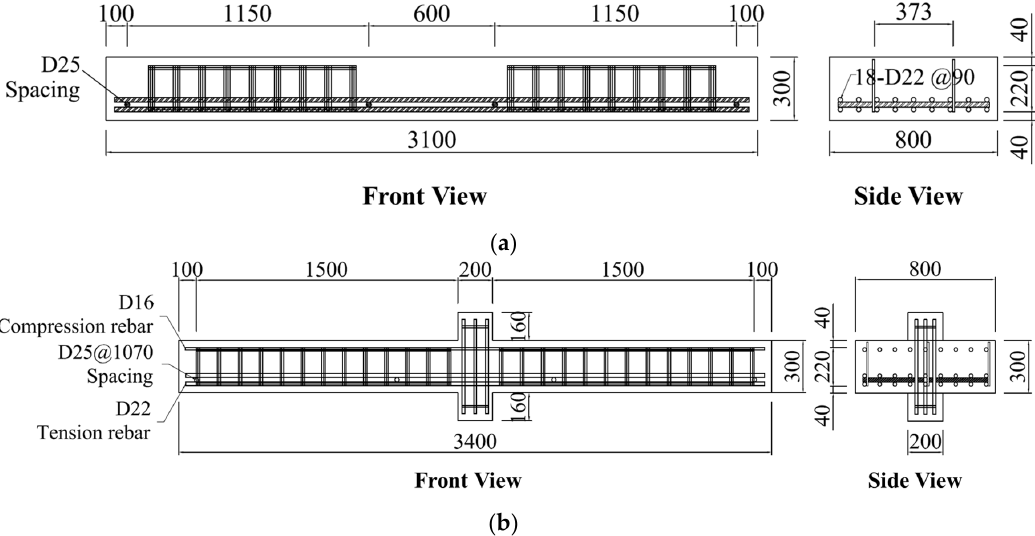
Figure 2. Details of specimens [mm]: ( a ) general wide beam (1S-N373); ( b ) wide beam with column support (1S-IC1).